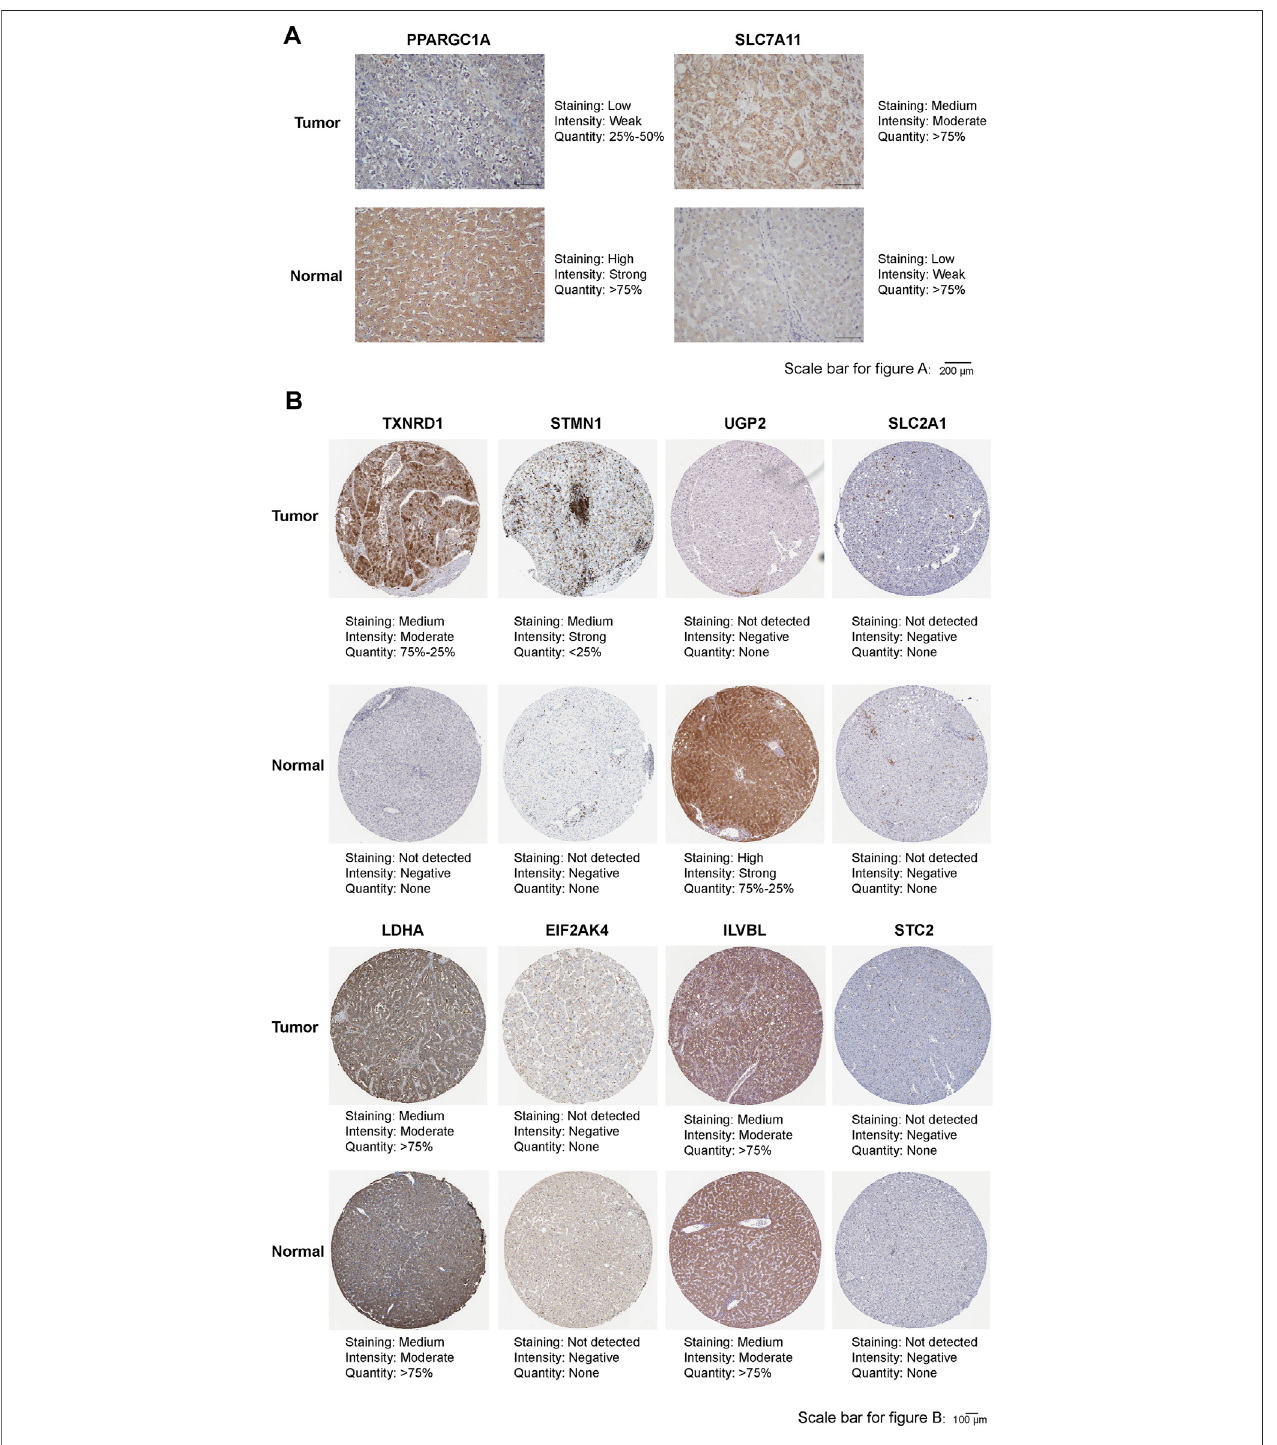
FIGURE 10 | (A) Representative immunohistochemistry images of PPARGC1A and SLC7A11 in HCC tissues and adjacent normal tissues. (B) Representative immunohistochemistry images of TXNRD1, STMN1, UGP2, SLC2A1, LDHA, EIF2AK4, ILVBL, and STC2 in HCC tissues and normal tissues.